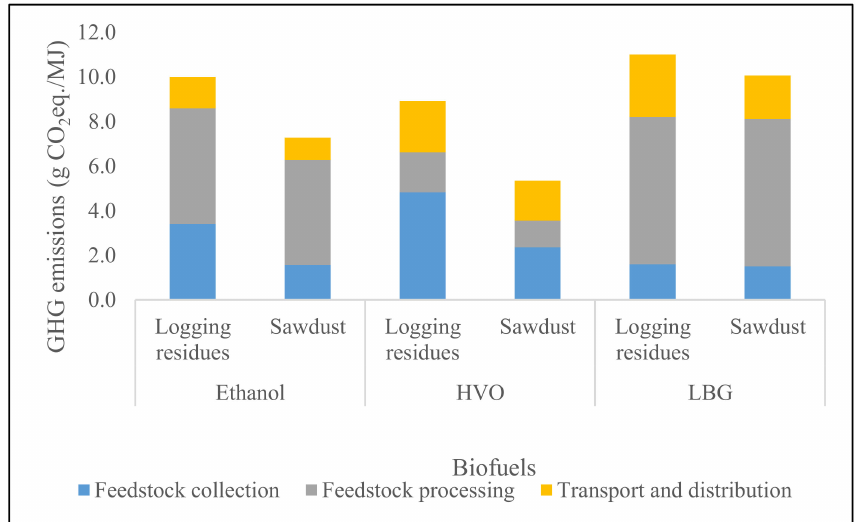
Figure 2. Well to tank greenhouse gas (GHG) performances of ethanol, hydro-processed vegetable oil (HVO) and liquefied biogas (LBG) from forestry residues and